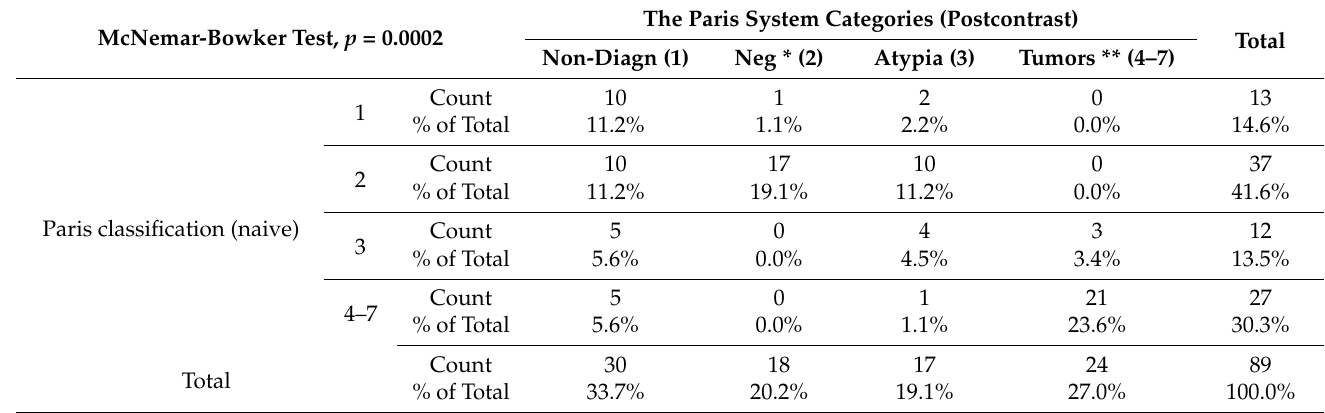
Table 4. Crosstabulation of naive and postcontrast urine specimens according to The Paris System. McNemar-Bowker Test, p = 0.0002